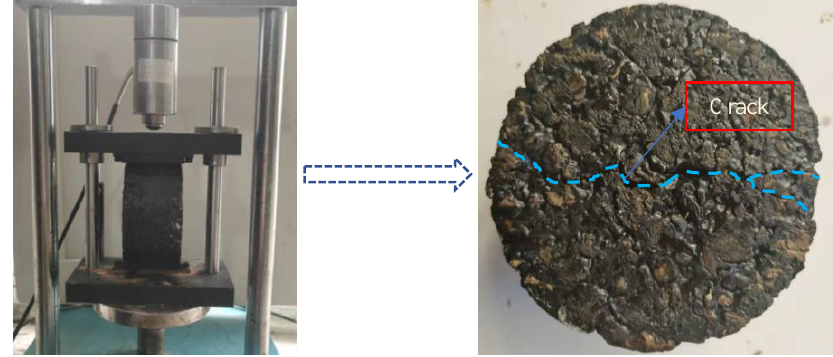
Figure 5. Marshall specimen with crack.